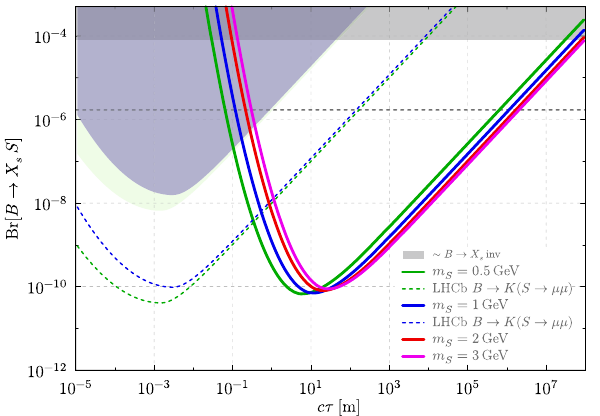
Fig. 10 ReachofCODEX-bforLLPsproducedin B -mesondecays,in a non-minimal model. Also shown is the current (shaded) and projected (dashed) reach for: LHCb via B → K ( ∗ ) ( S → μμ) , for m S = 0 . 5GeV (green) and m S = 1GeV (blue), assuming a muon branching ratio of 30% and 10%, respectively (see Ref. [8]); and for B → K ( ∗ ) + inv. (gray)